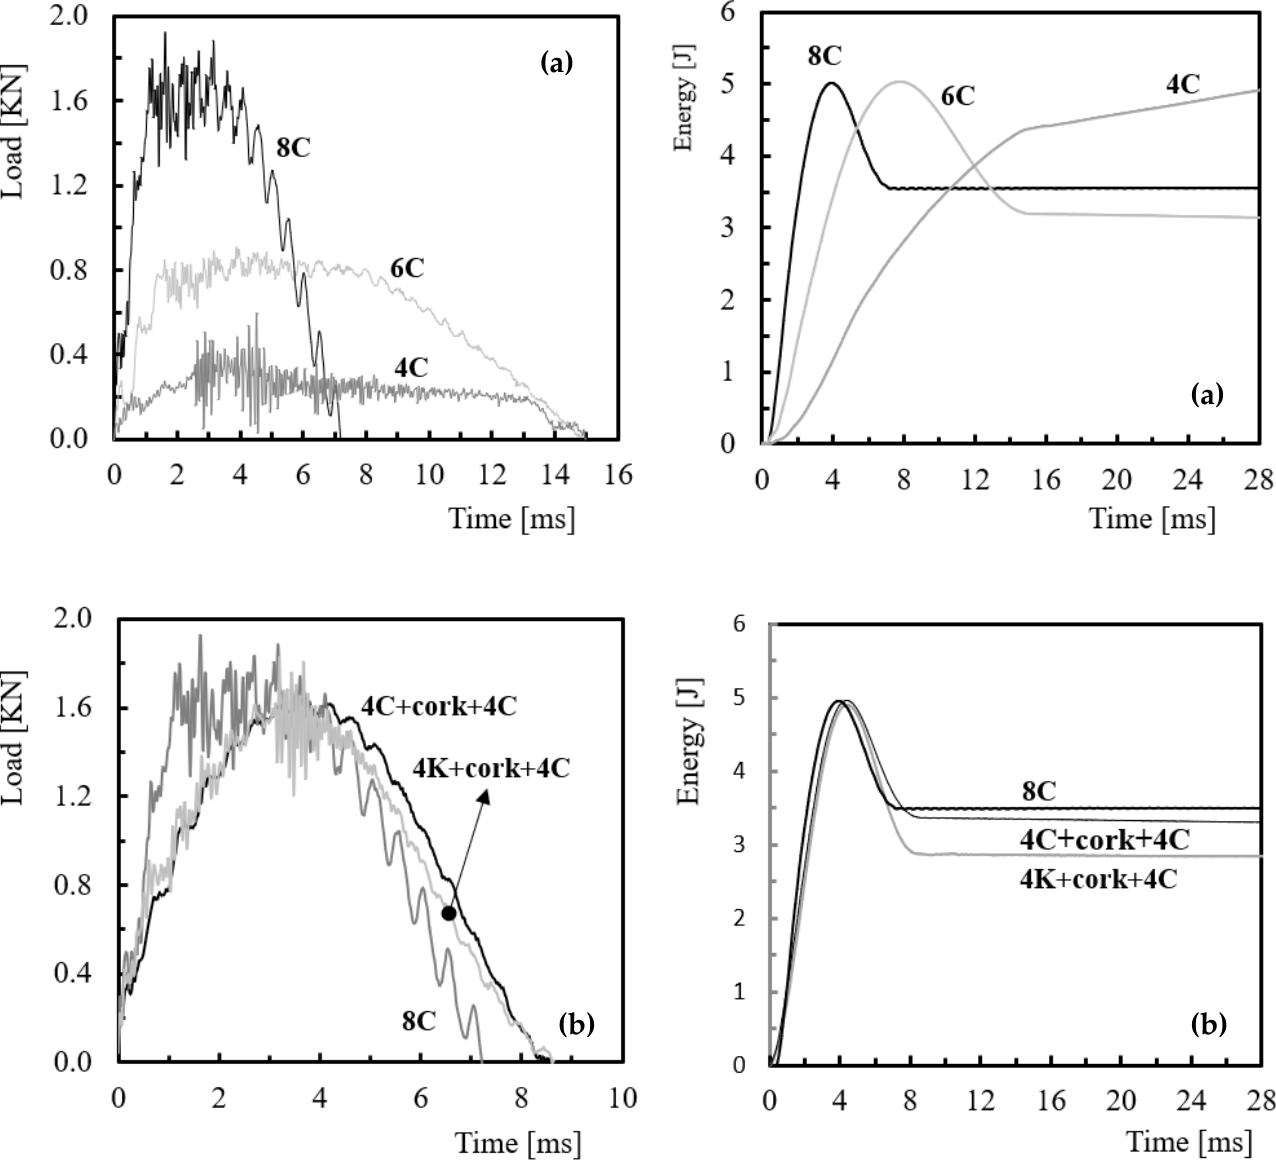
Figure 7. Load–time and energy–time curves for: ( a ) composite cylindrical shells with different thicknesses; ( b ) composite sandwich cylindrical shells.